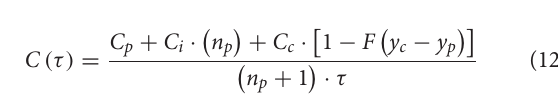
Frontiers in Built Environment |